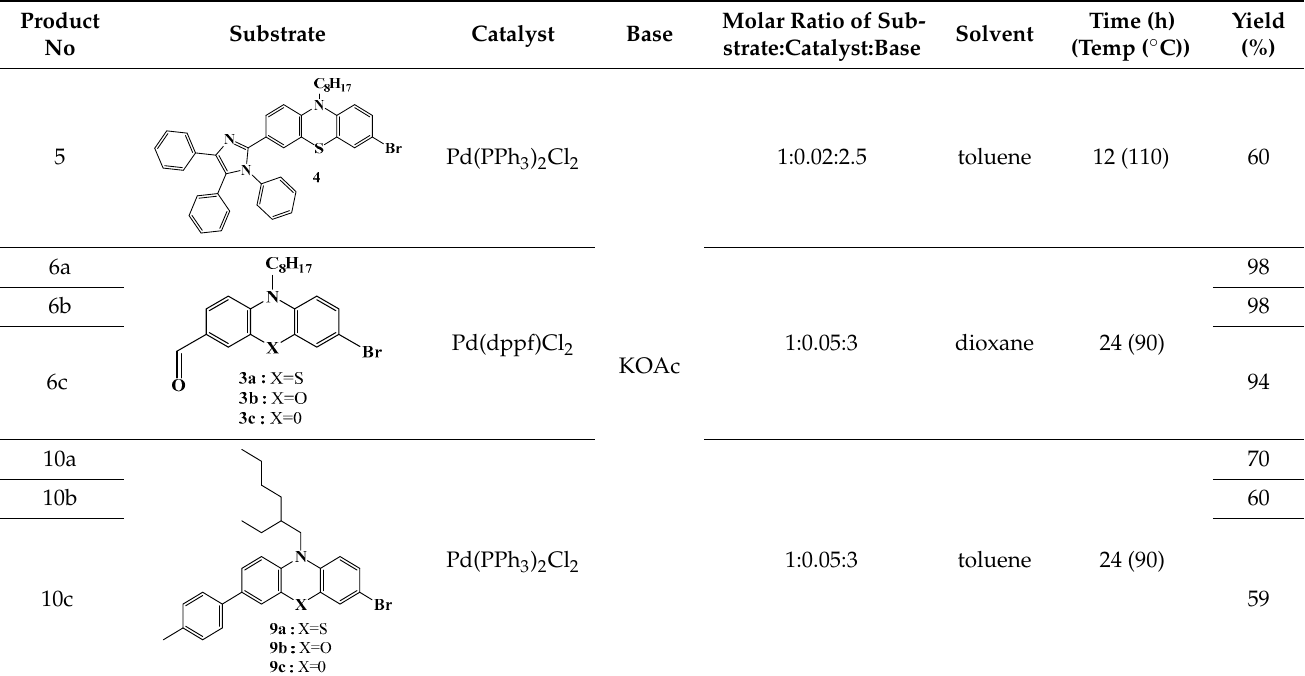
Table 1. Summary of the Miyaur borylation reaction of brominated N -alkyl PTZ, POZ, and Cz couplers.